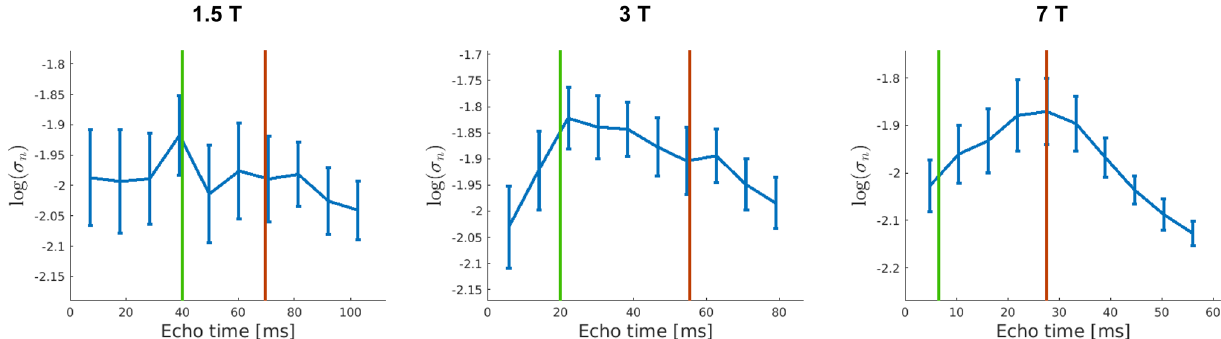
Figure 5. Average physiological noise level over subjects and standard error for the studied echo times in the middle of the cortex at 1.5 T (left), 3 T (middle) and 7 T (right). The green vertical line marks the venous T2* and the red vertical line marks the T2* of tissue at each field. Only the curve at 7 T is significantly different from a flat line (p =